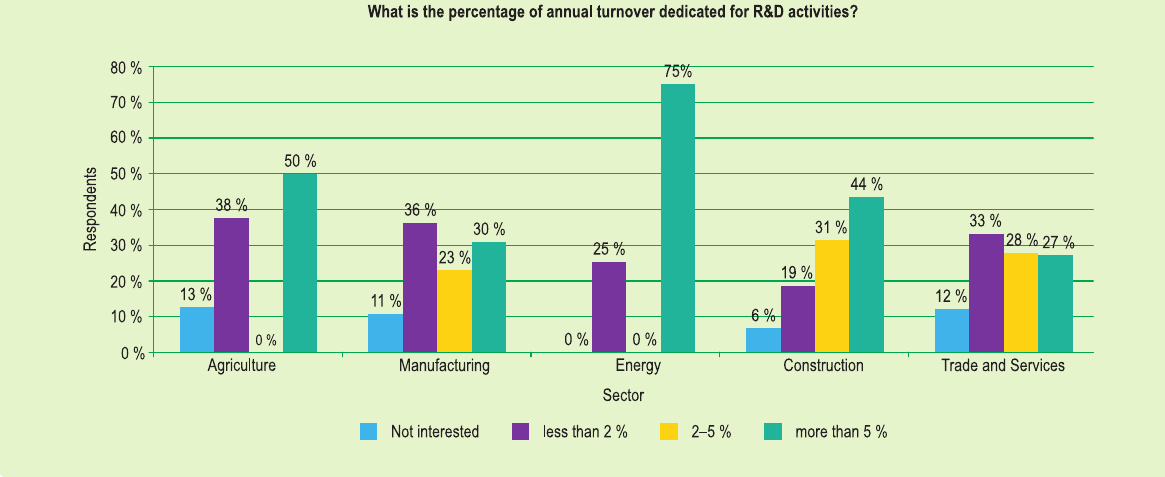
Fig 1. Percentage of dedicated funds for Research and Development activities for businesses with no FDI